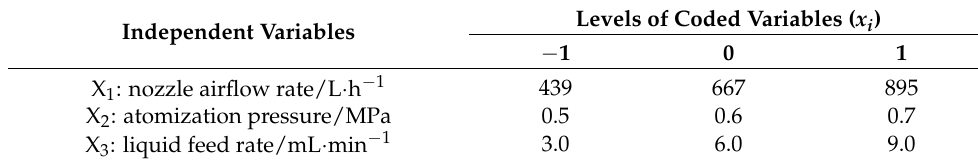
Table 1. Coded and actual levels of independent variables for Box–Behnken design. Levels of Coded Variables ( x i Independent Variables